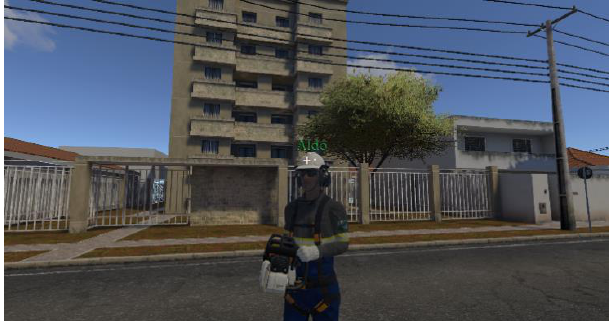
Figure 9. An electrician with PPE and the chainsaw, ready to prune a tree.